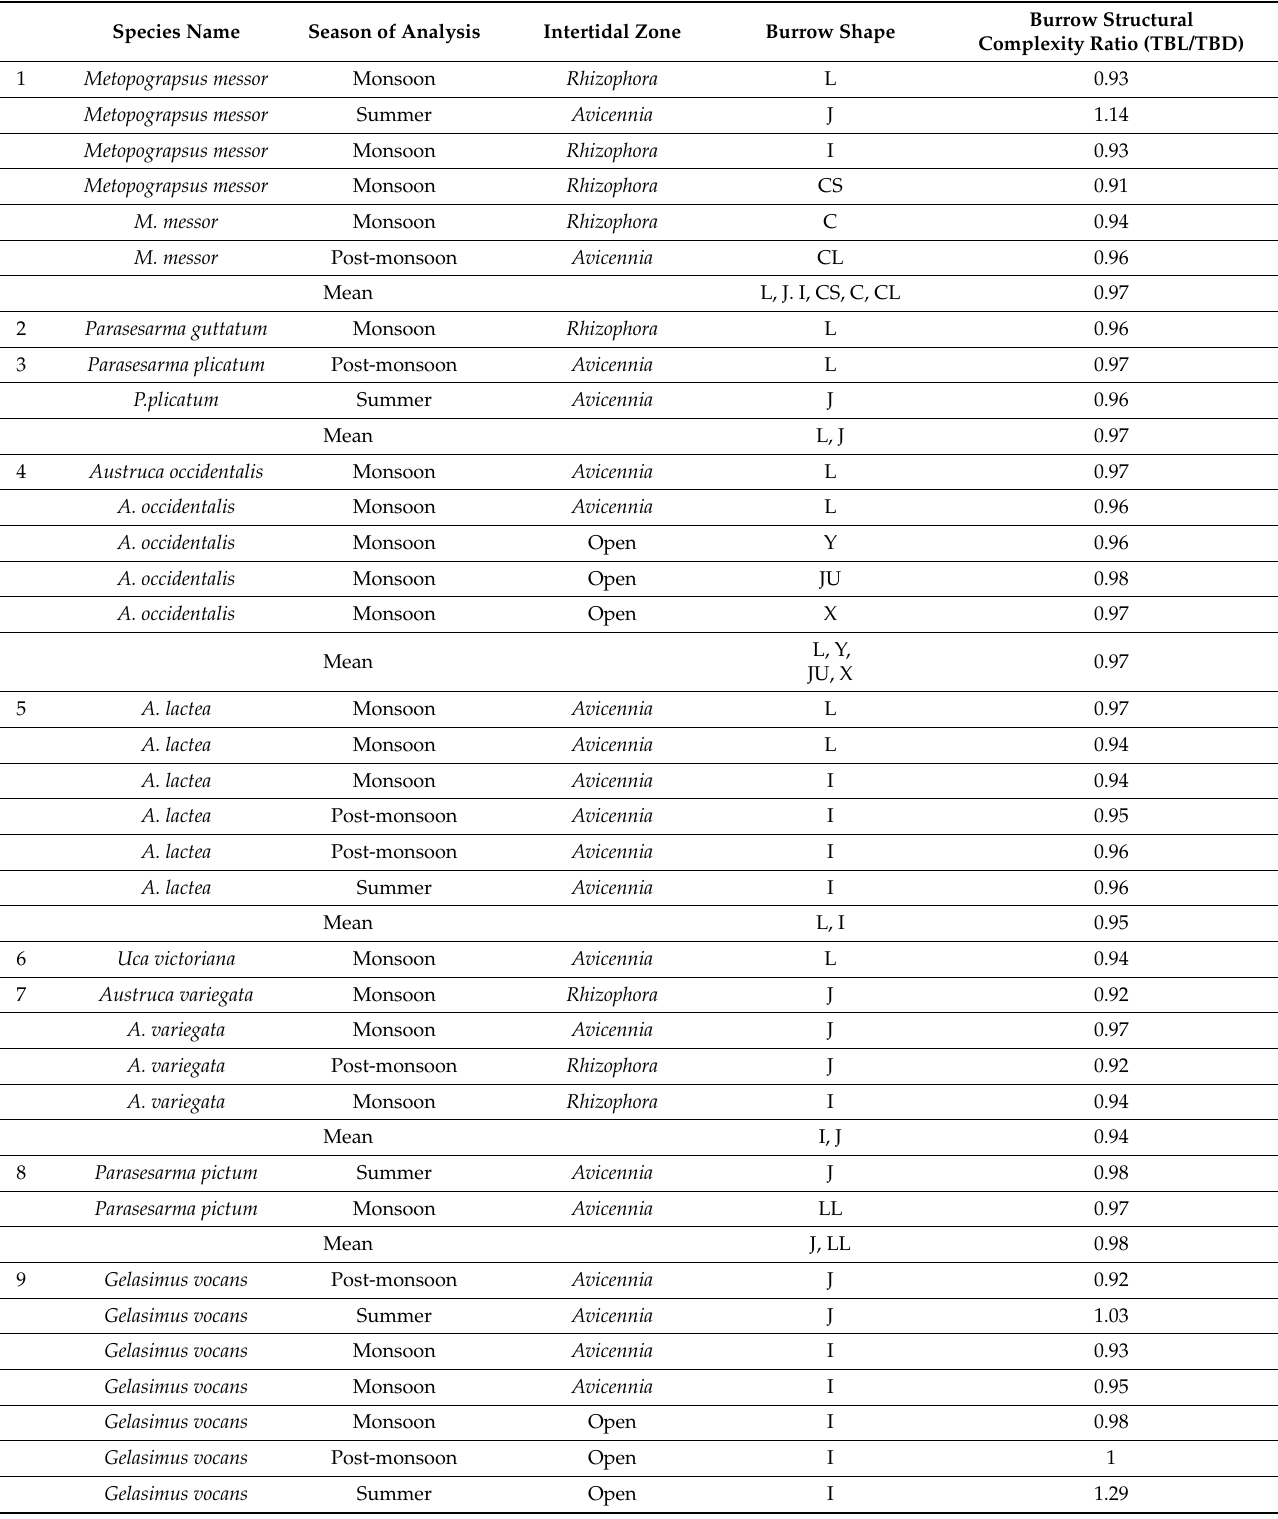
Table 1. Burrow shape and its structural complexity ratio across three intertidal zones under three seasons of analysis in the restored mangrove